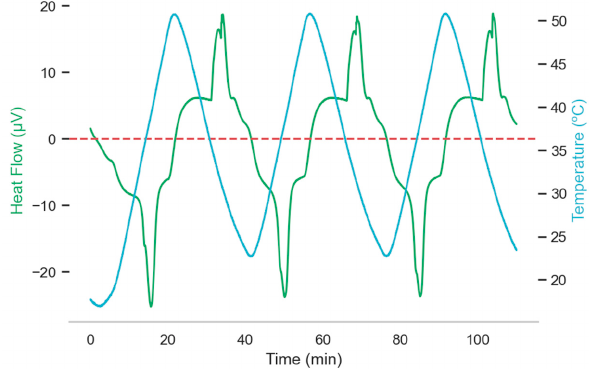
Figure 7. Endo- and exothermic transformations in two reversible cycles.